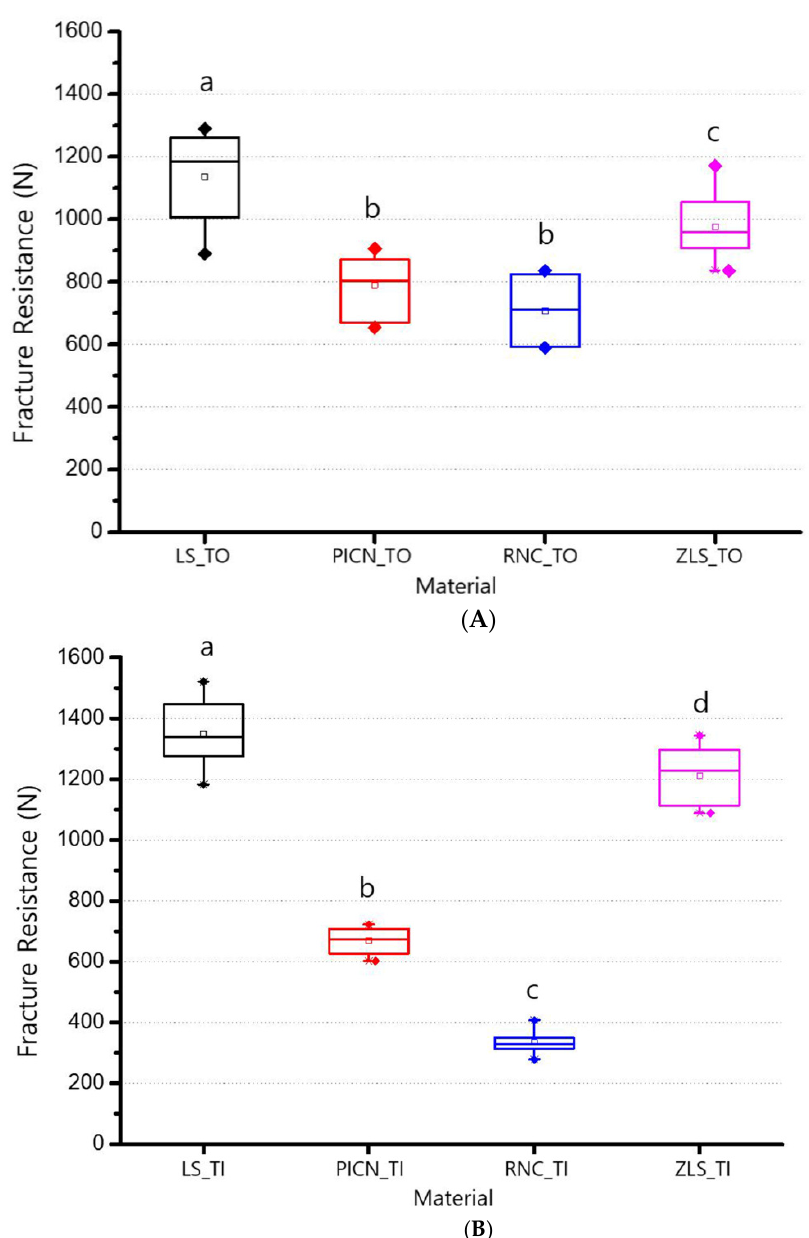
Figure 2. Means and standard deviations of fracture resistance. ( A ): Tooth abutment. ( B ): Titanium abutment. Same alphabet letters indicate no significant differences at p < 0.05. LS, lithium disilicate; PICN, polymer-infiltrated-ceramic-network; RNC, resin nano ceramic; ZLS, zirconia-reinforced lithium silicate; TO, tooth abutment; TI, titanium abutment.